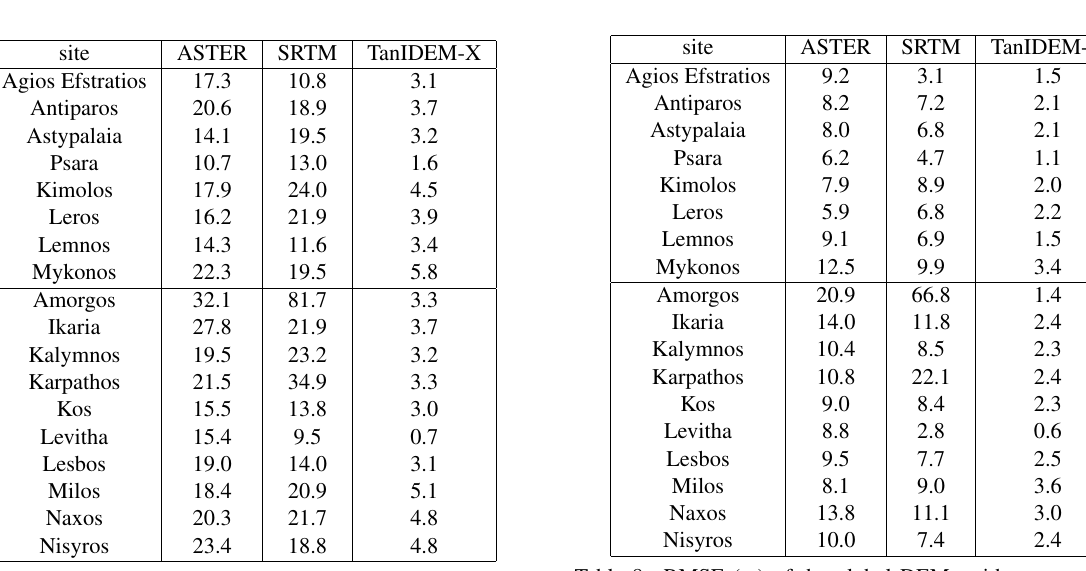
Table 6. RMSE (m) of the global DEMs with respect to local elevation data. (DX,DY) as shown in Table 5.